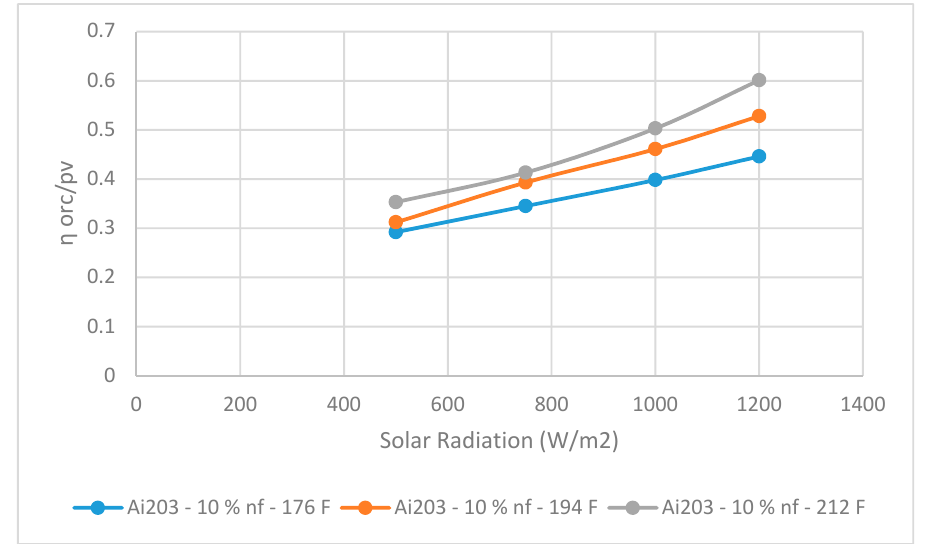
Figure 10. Hybrid system efficiency for Nanofluid Al 2 O 3 different temperatures and 10% volumetric concentration.